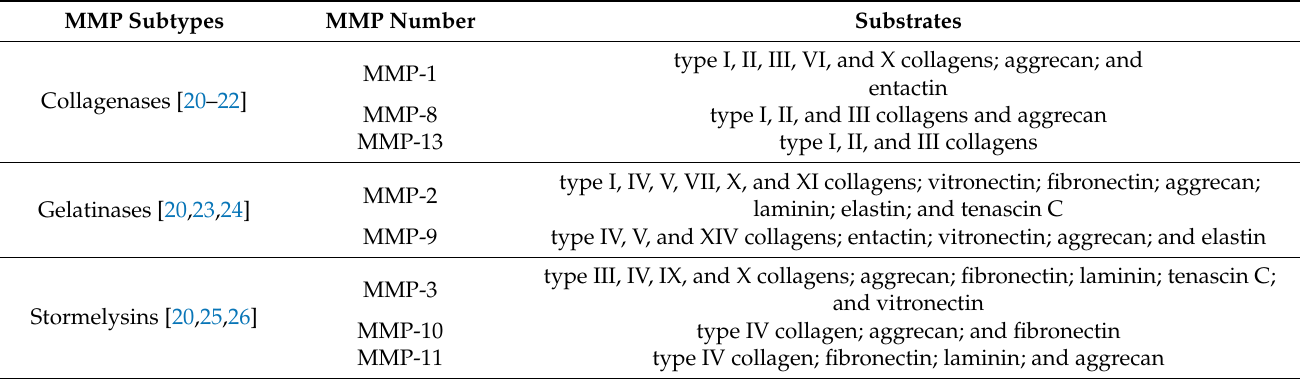
Table 1. Matrix metalloproteinase (MMP) subtypes and substrates.